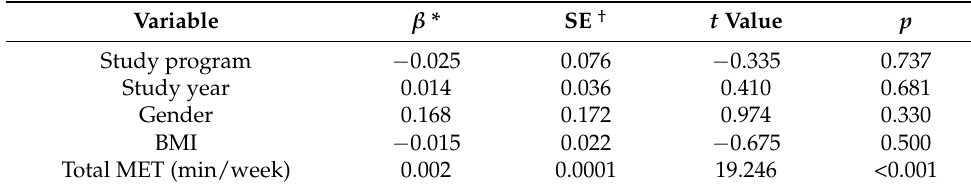
Table 5. Multiple linear regression model of independent predictors for knowledge questionnaire results.